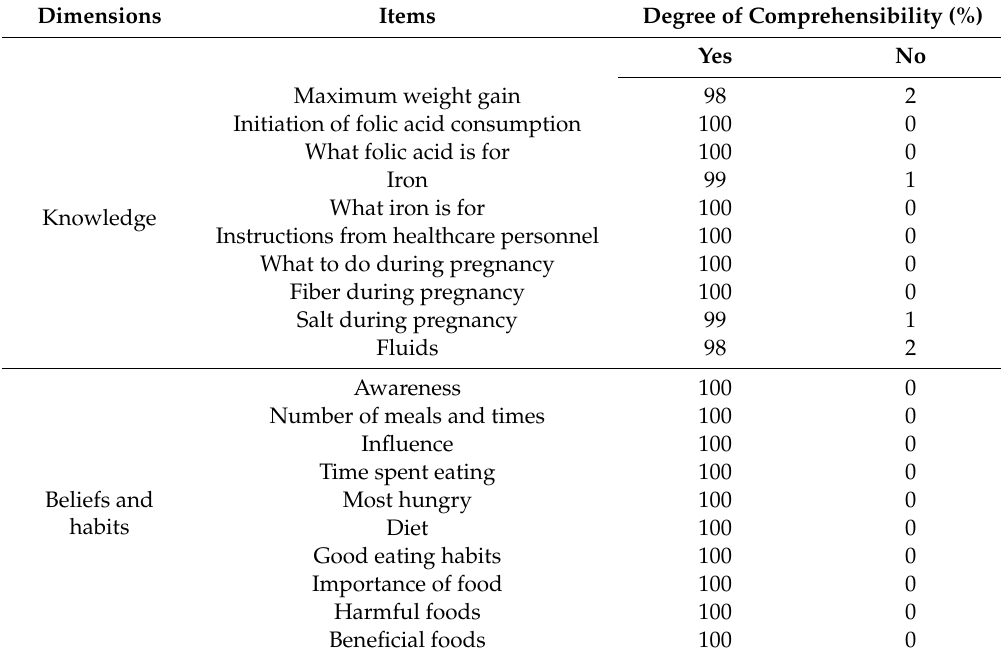
Table 7. Percentages of comprehensibility of the dimensions and their items in the final version of the validated